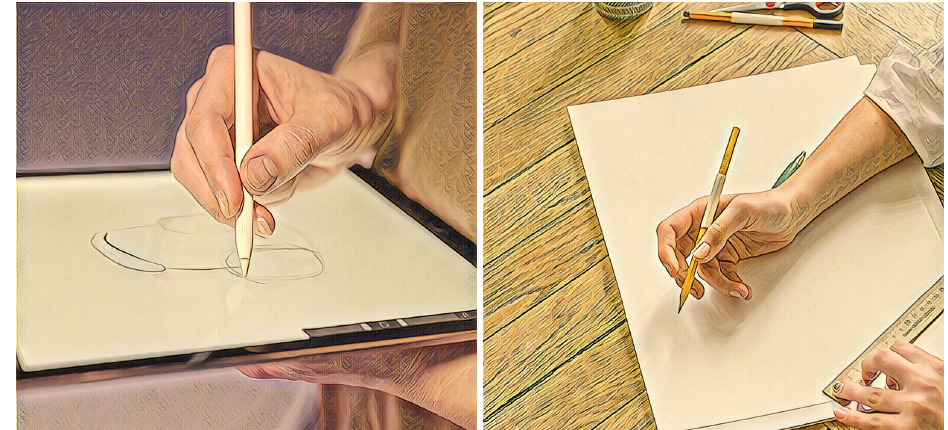
Figure 4. Illustrations of telestration interaction styles.